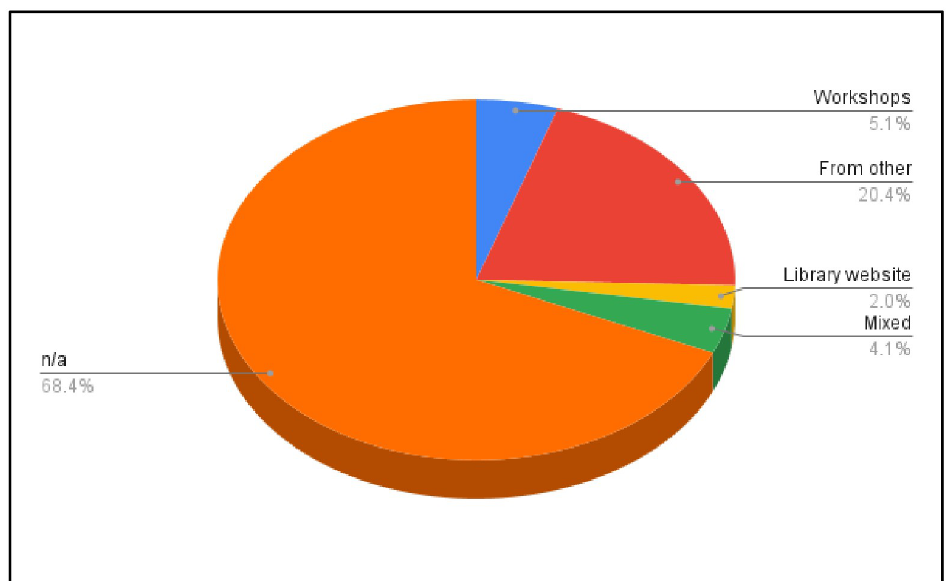
Fig 1. Distribution of the method of hearing about